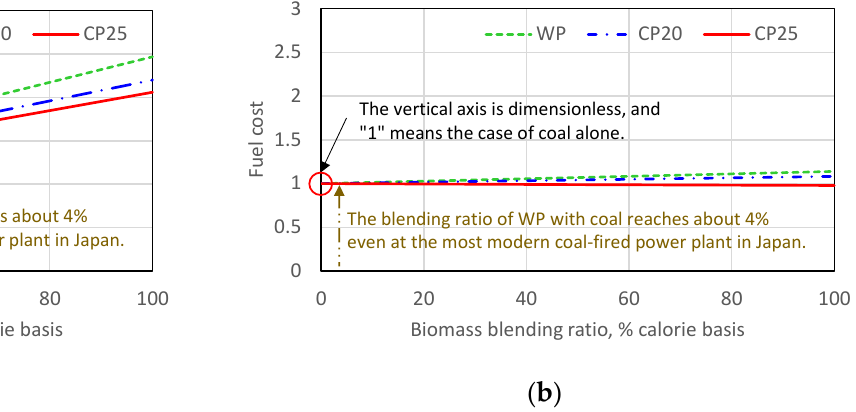
Figure 6. Estimated costs for generated electricity at a coal–biomass co-firing power plant in Japan: ( a ) case of Canada; ( b ) case of Vietnam.